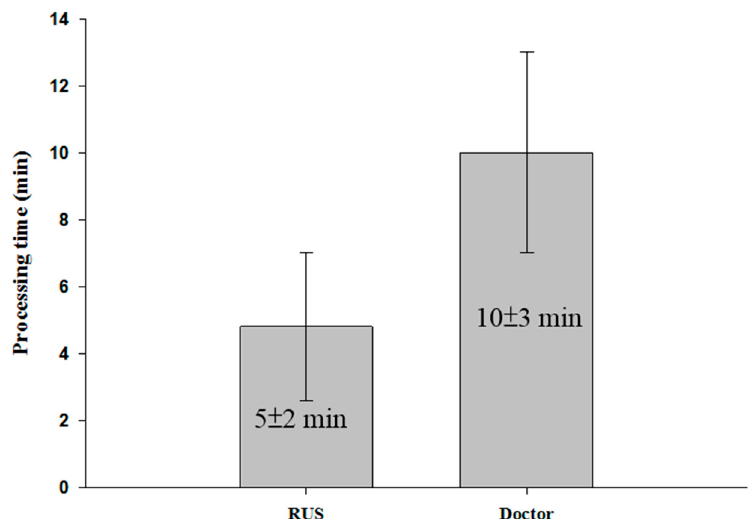
Figure 12. Comparison of processing time.